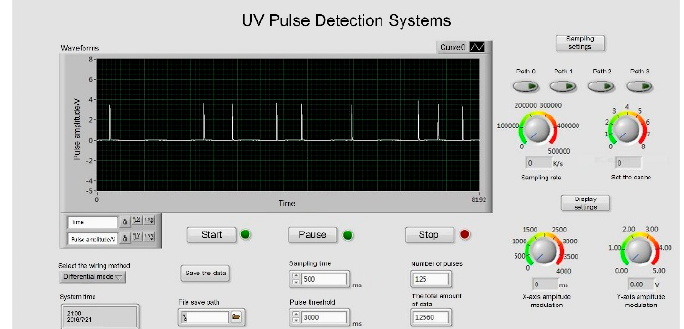
Figure 8. UV discharge detection system test.